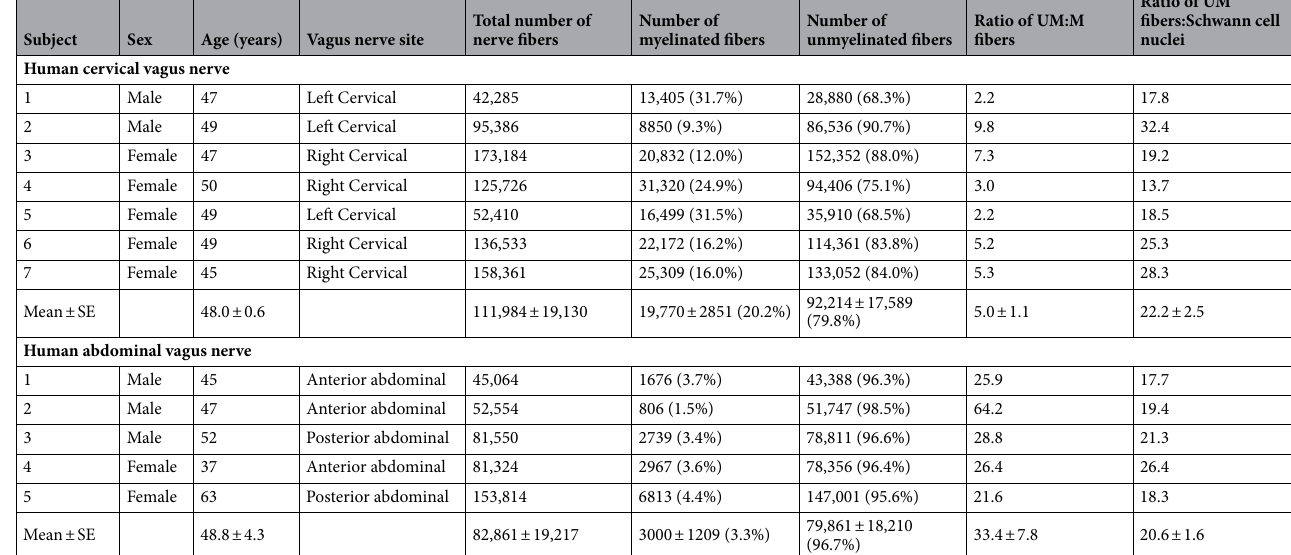
Table 1. Summary of transmission electron microscopy studies of segmented myelinated and unmyelinated axons of the cervical and abdominal human vagus nerve. UM unmyelinated fibers, M myelinated fibers.